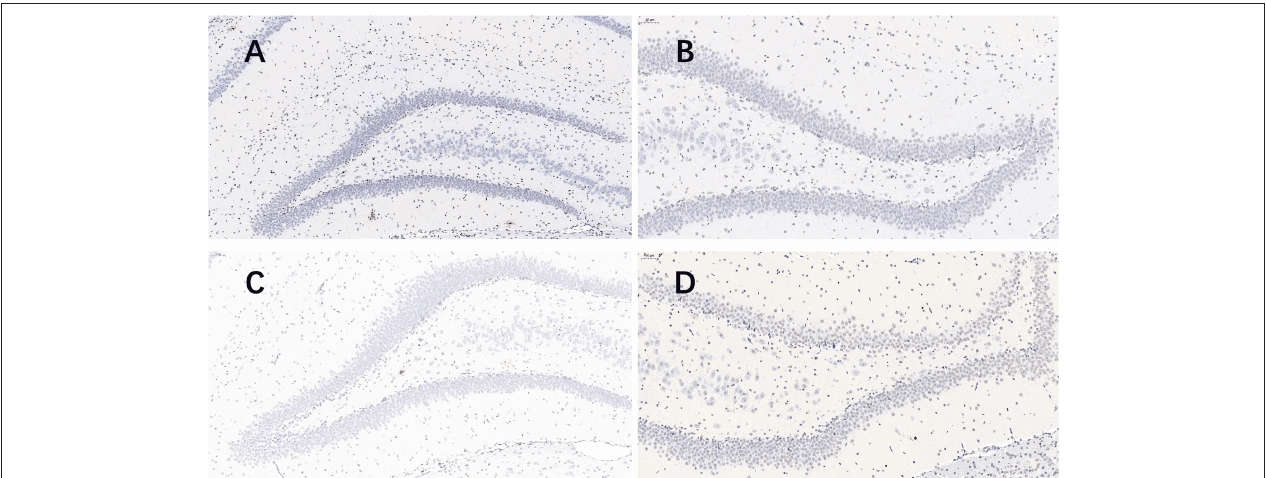
FIGURE 2 | Nissl stained pictures of the hippocampus. When taking screenshots, try to fill the field of whole tissue, make sure that the background light of each photo is consistent. The nuclei of the surviving neurons were large and round, pale blue or blue, with clear nucleoli and abundant cytoplasm. (A) plateau group, 24h after the last seizure; (B) plain group, 24h after the last seizure; (C) plateau group, 72h after the last seizure; (D) plain group, 72h after the last seizure (20.0 × ).